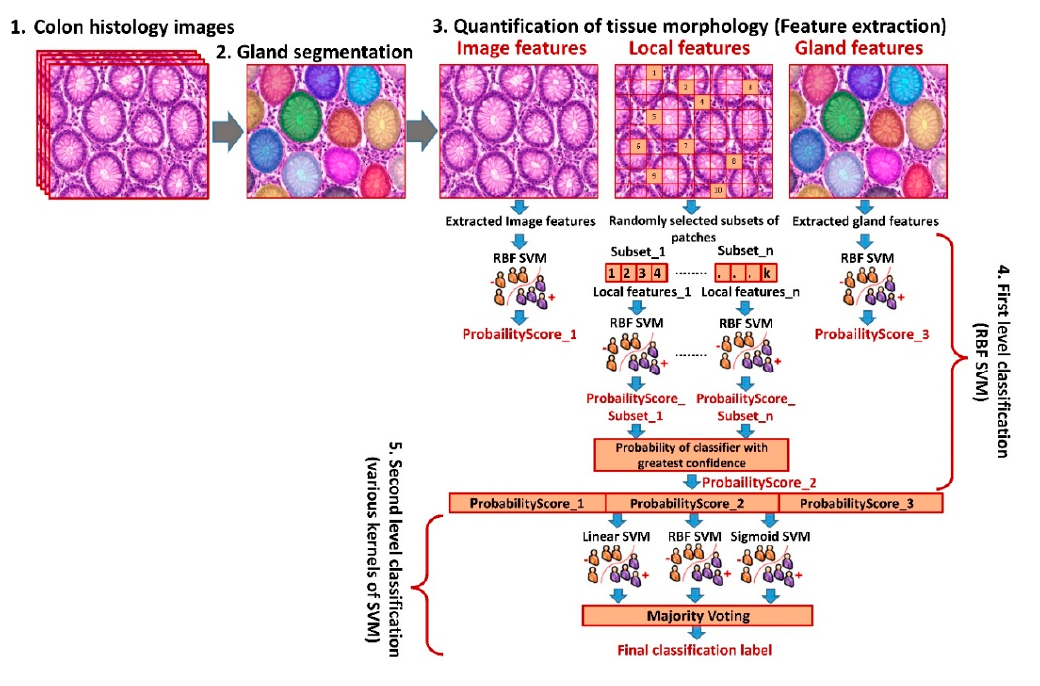
Figure 2. Schematic overview of the proposed methodology: ( 1 ) Colon tissue histology images, ( 2 ) gland segmentation using the proposed multi-step method, ( 3 ) quantification of tissue morphology, ( 4 ) first level of classification using radial basis function (RBF) kernel of support vector machine (SVM), and ( 5 ) second level of classification using majority voting based on the predictions of various weak classifiers such as linear, RBF, and sigmoid kernel of SVM .